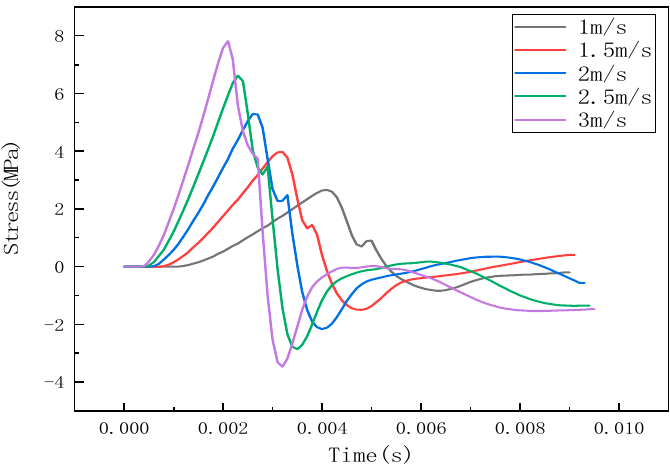
Figure 7. Impact force curve at position 1.